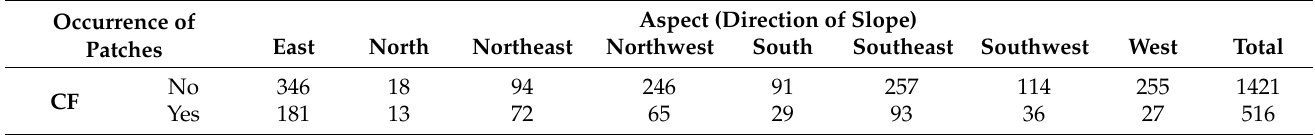
Table A3. Patches of forest cover and the direction of slope